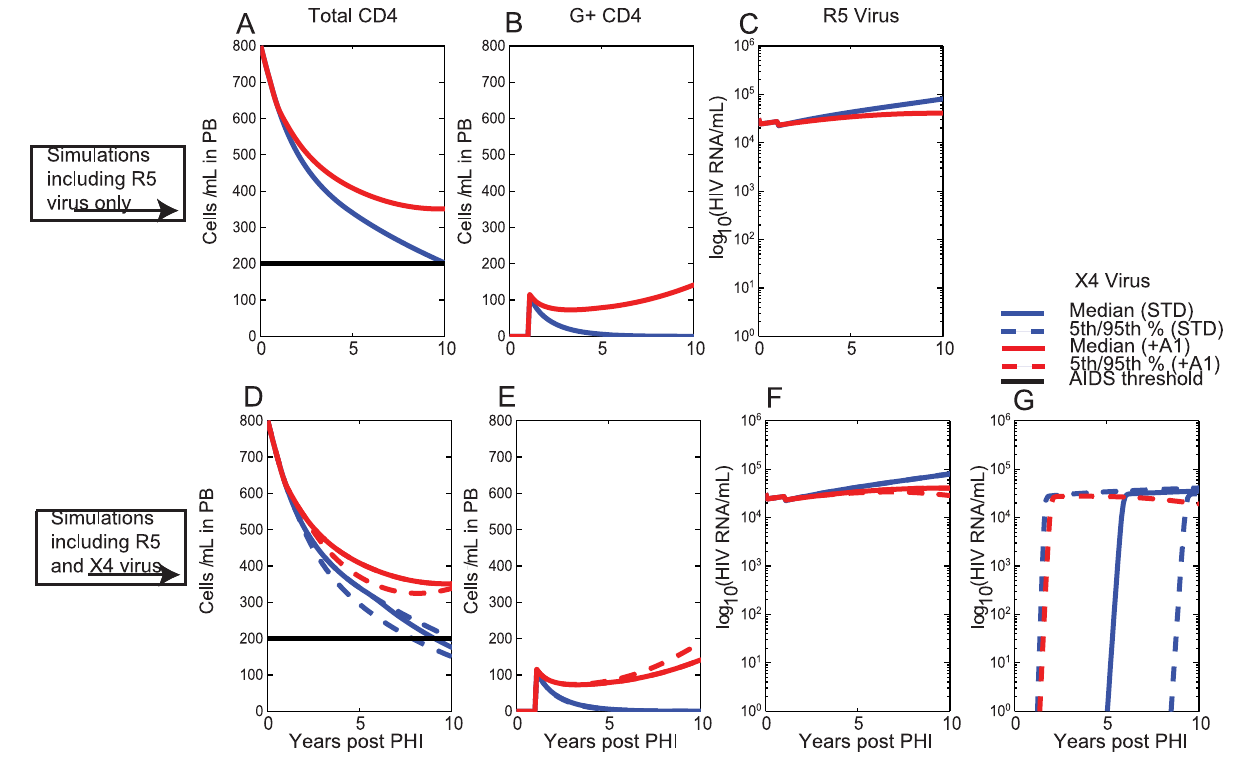
Figure 3. One-off delivery of gene therapy to CD4 + T cells assuming that 20% of CD4 + T cells receive the gene construct at year 1. Therapy is administered at year 1. Shown are the simulation outcomes under the standard scenario (STD) and under Assumption + A1 of reduced bystander apoptosis in G + CD4 + T cells ( + A1); Solid lines denote median values, dashed lines denote the 5 th and 95 th percentile ranges for outcomes when 6 4 virus can develop. Also shown is the AIDS threshold of 200 cells/ m L (solid horizontal black line); A) Total CD4 + T cell count, B) G + CD4 + T cell count and C) R5 Viral Load for a single simulation with R5 virus only (i.e. assuming V X 4 t ð Þ ~ 0 throughout the course of infection); D) Total CD4 + T cell count, E) G + CD4 + T cell count F) R5 Viral Load and G) 6 4 Viral Load for Monte Carlo simulations assuming initial infection with R5 virus, but now including 6 4 virus. Monte Carlo simulations were performed for 100 trials and involved repeated sampling of parameter D g from a uniform distribution (see Methods and Table